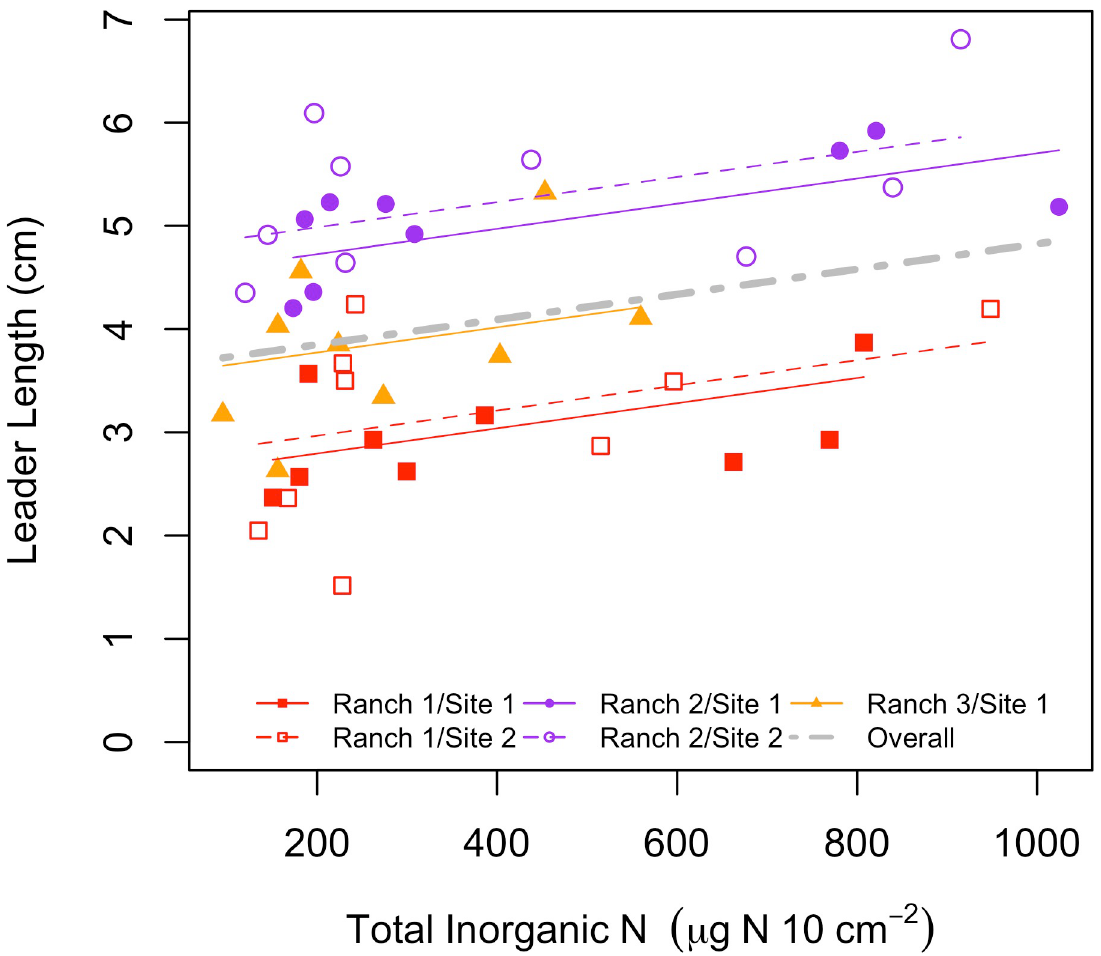
Fig 3. Relationship between sagebrush leader growth and total inorganic N for each of five sites in Pinedale, WY. Ranch location is indicated by color, while sites within a ranch differ in shape (note: Ranch 3 has only a single site). Solid lines correspond to the site with the solid color shapes and dashed lines correspond to the hollow/un-filled shapes. Data presented is across all treatments.